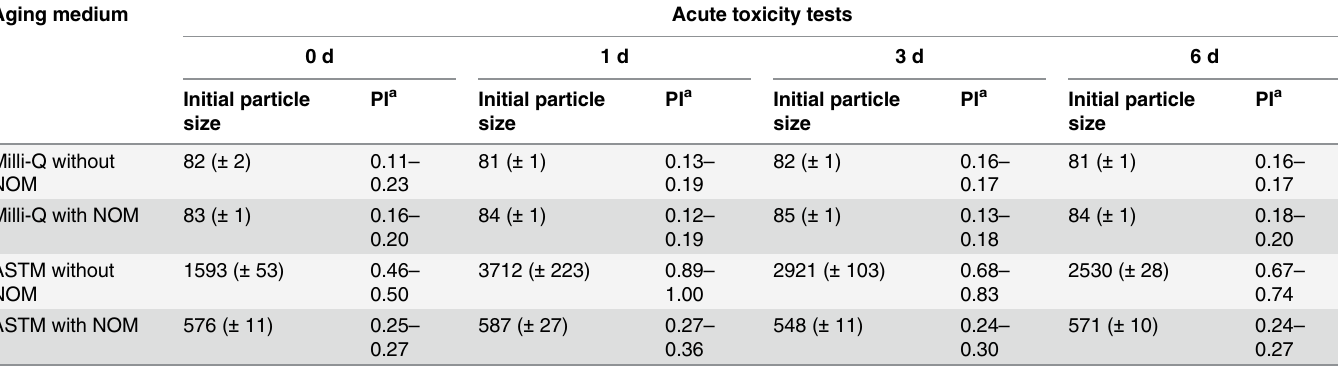
Table 1. nTiO 2 size after aging.